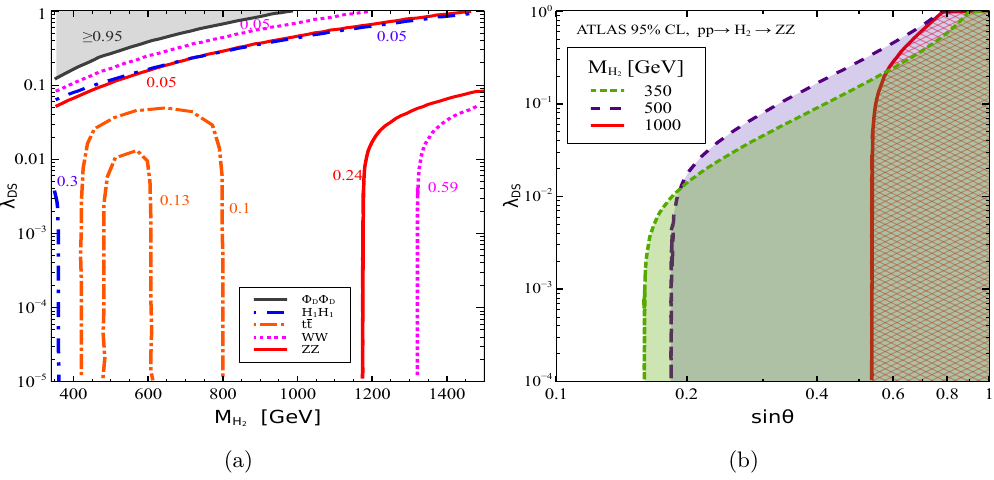
- λ plane φ D /ZZ/W + W − /H 1 H 1 /t ¯ t ) in M H SD D 2 plane derived from the ATLAS search for SD 4 l [53]. 2 → ZZ →